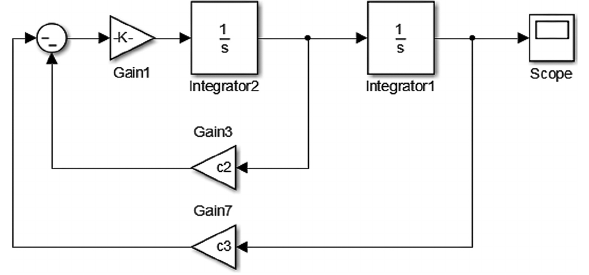
Fig. 10. Subsystem of oscillations